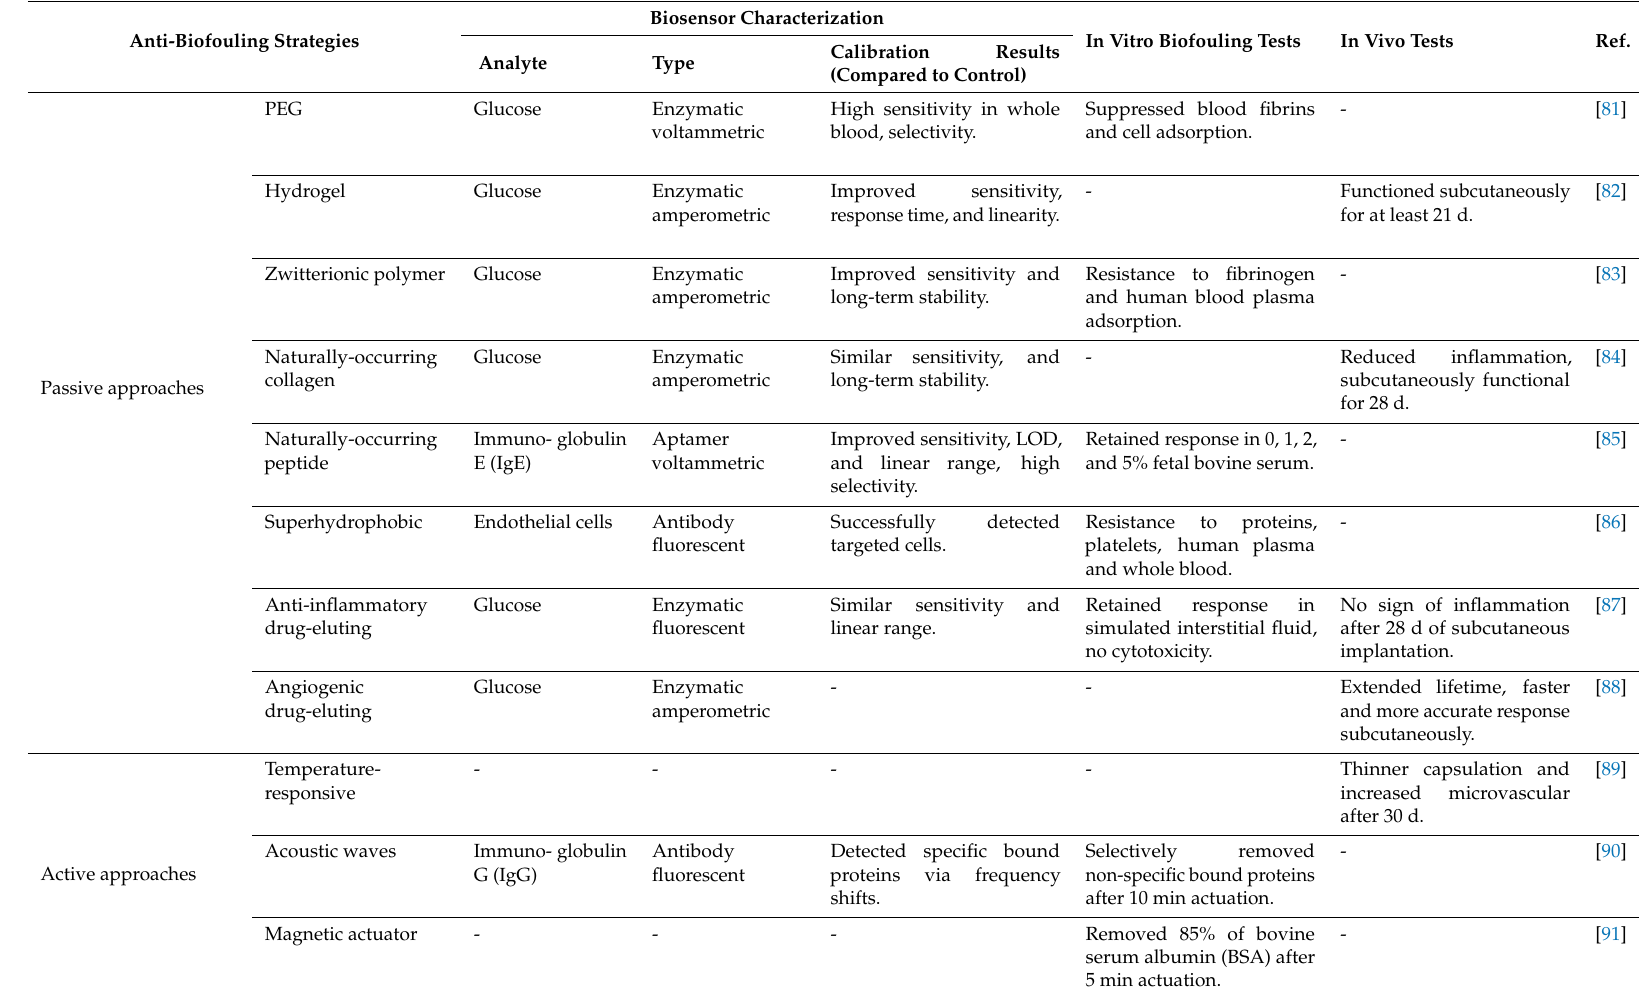
Table 2. Selected studies of various anti-biofouling strategies for implantable biosensor